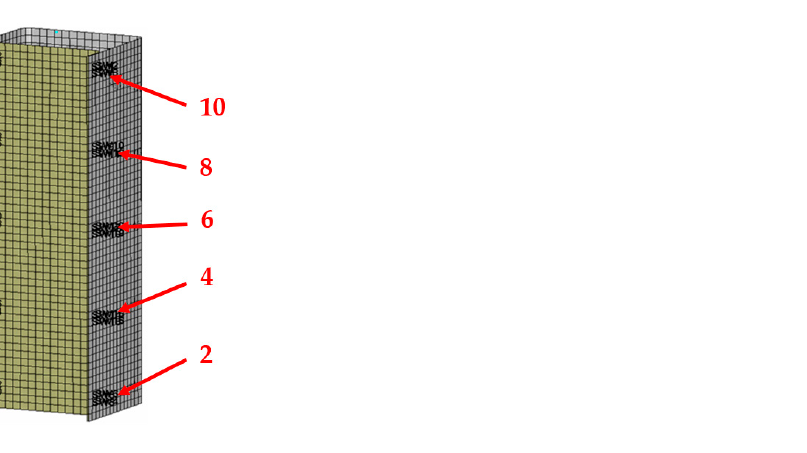
Figure 20. Positions and labelling (Table A3) of the spot-welded joints in the FE model.